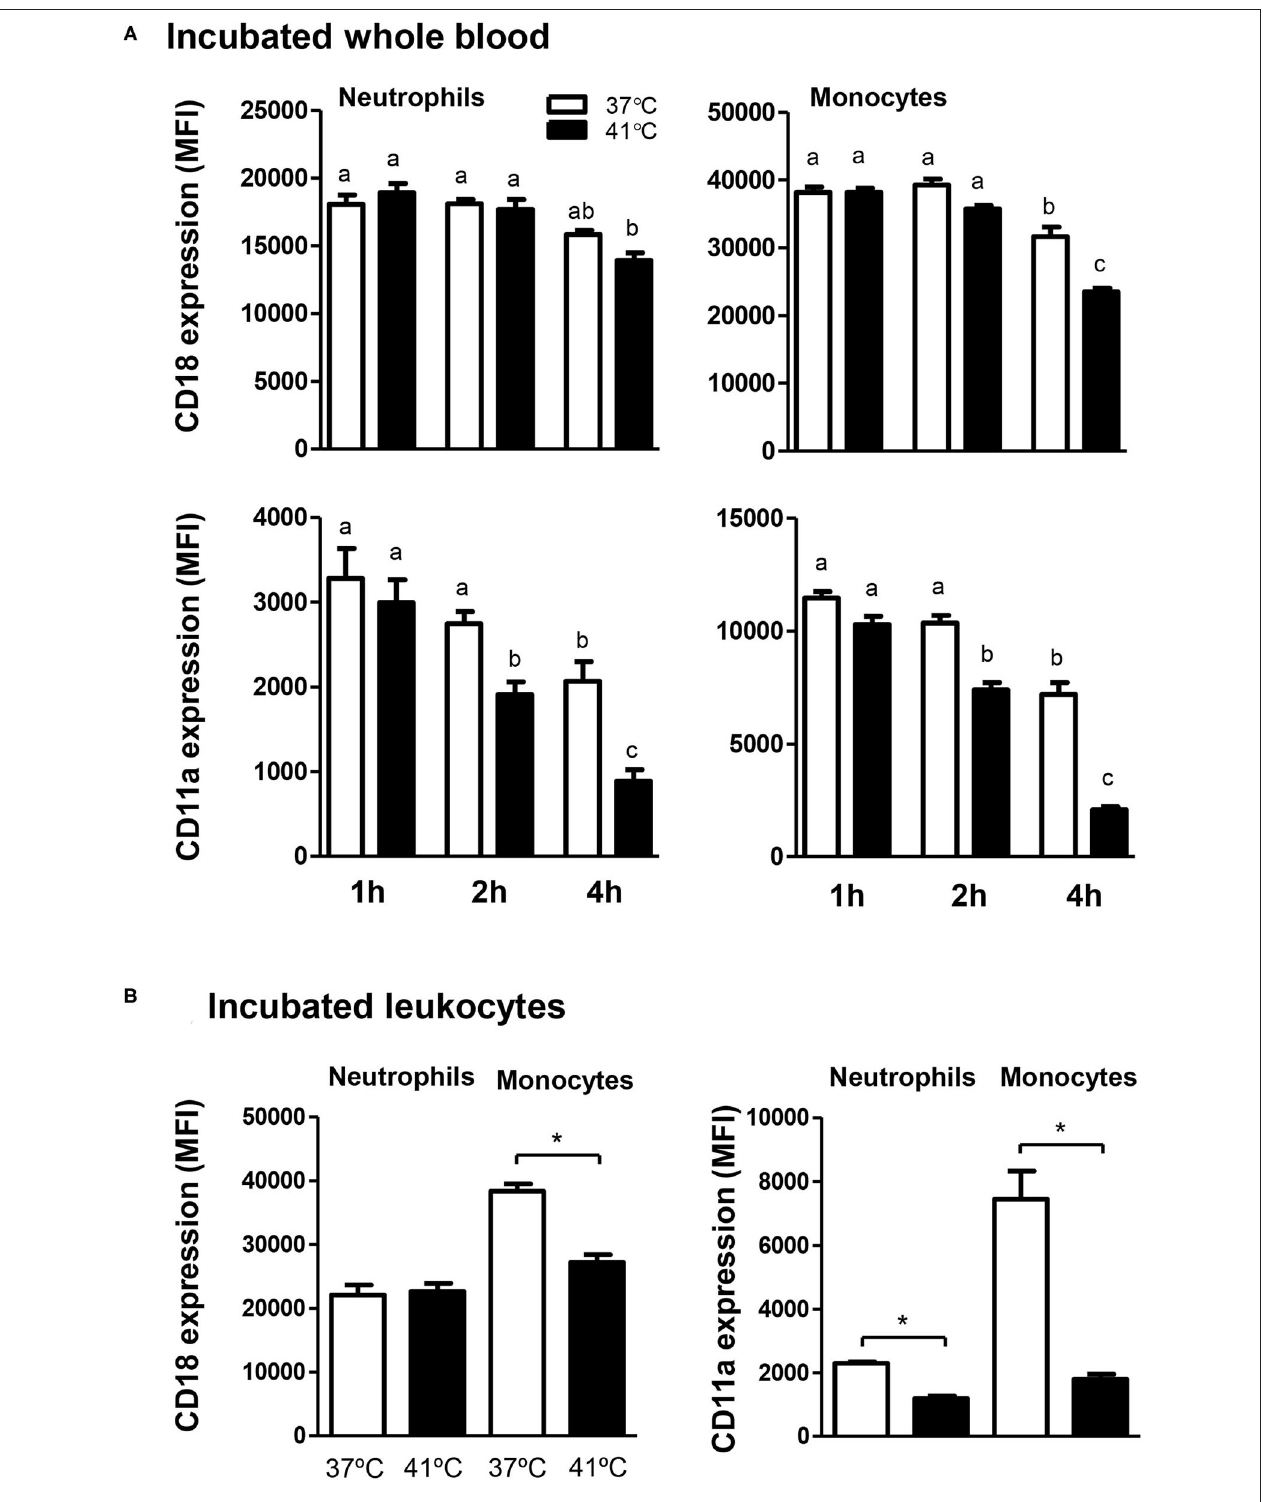
FIGURE 7 | The effect of heat stress on adhesion molecules expression on camel neutrophils and monocytes. Leukocytes separated from heat-stressed whole blood (A) or heat-stressed leukocytes (B) were labeled with monoclonal antibodies to CD18 and CD11a and labeled cells were analyzed by flow cytometry. After setting gates on neutrophils and monocytes, the expression levels of CD18 and CD11a were calculated as MFI values and presented (mean ± SEM) for blood incubated at 37 and 41 ◦ C for 1, 2, and 4h. Different lower case letters indicate a significant difference between the groups, as analyzed using one-way ANOVA ( p < 0.05). For separated leukocytes, the student t -test was used for comparison between the means of cells incubated at 37 and 41 ◦ C (* indicates p < 0.05).